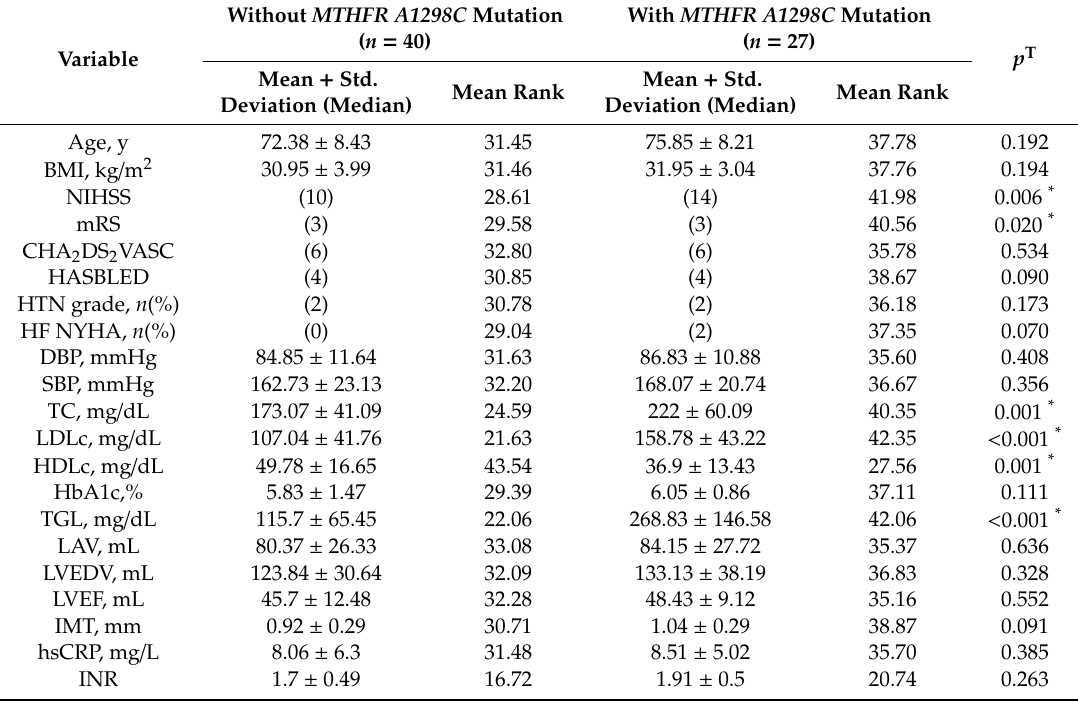
Table 3. Variable comparisons for MTHFR A1298C mutation ( n = 67) in all patients using the Mann–Whitney U